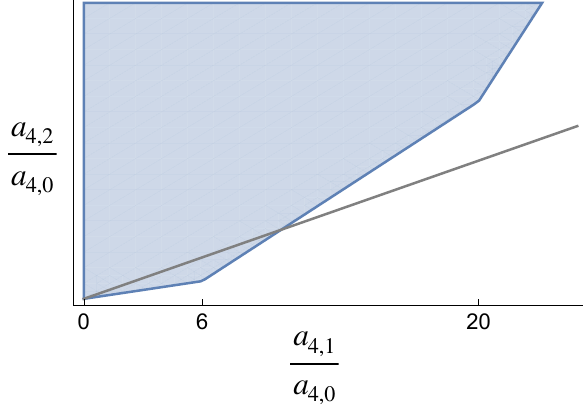
Figure 3 . 1. ( a 4 , 2 /a 4 , 0 , a 4 , 1 /a 4 , 0 ) polytope and a 4 , 2 = 8 a 4 , 1 symmetry plane.